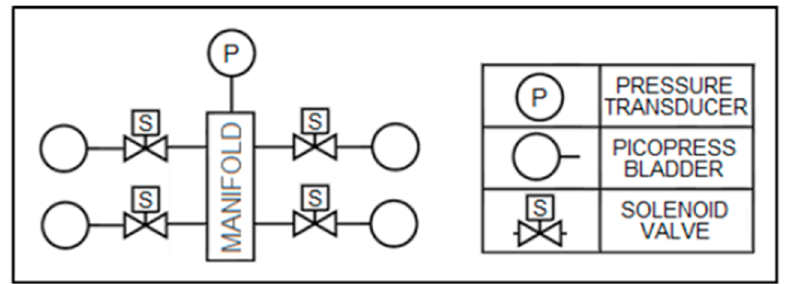
Figure 1. Multiplexing example of four pneumatic sensors.